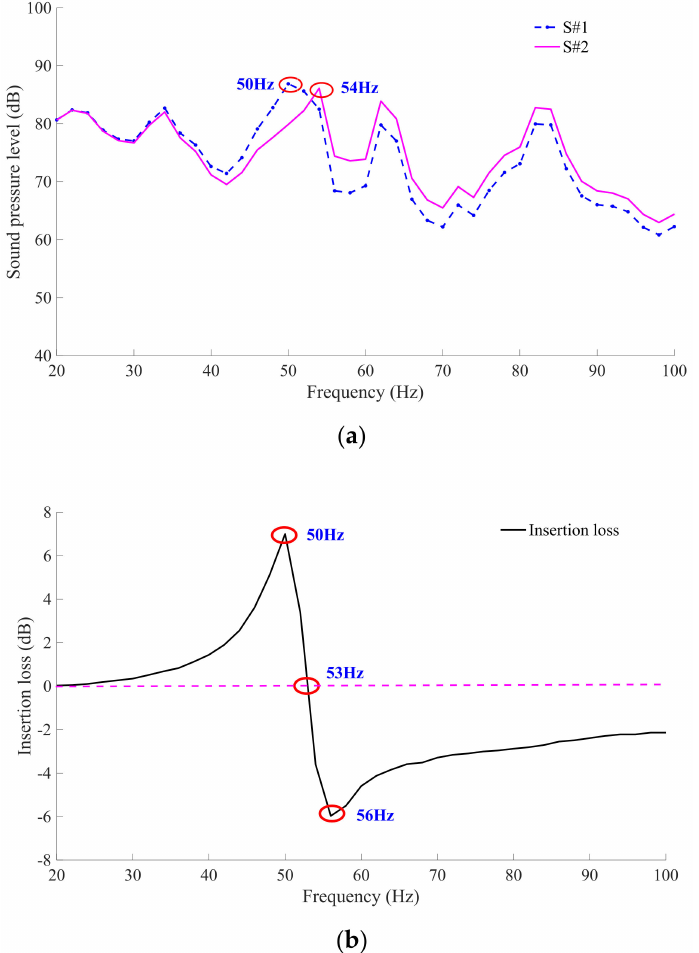
Figure 10. Sound pressure level and insertion loss at field point 2; ( a ) sound pressure level; ( b ) inser- tion loss.